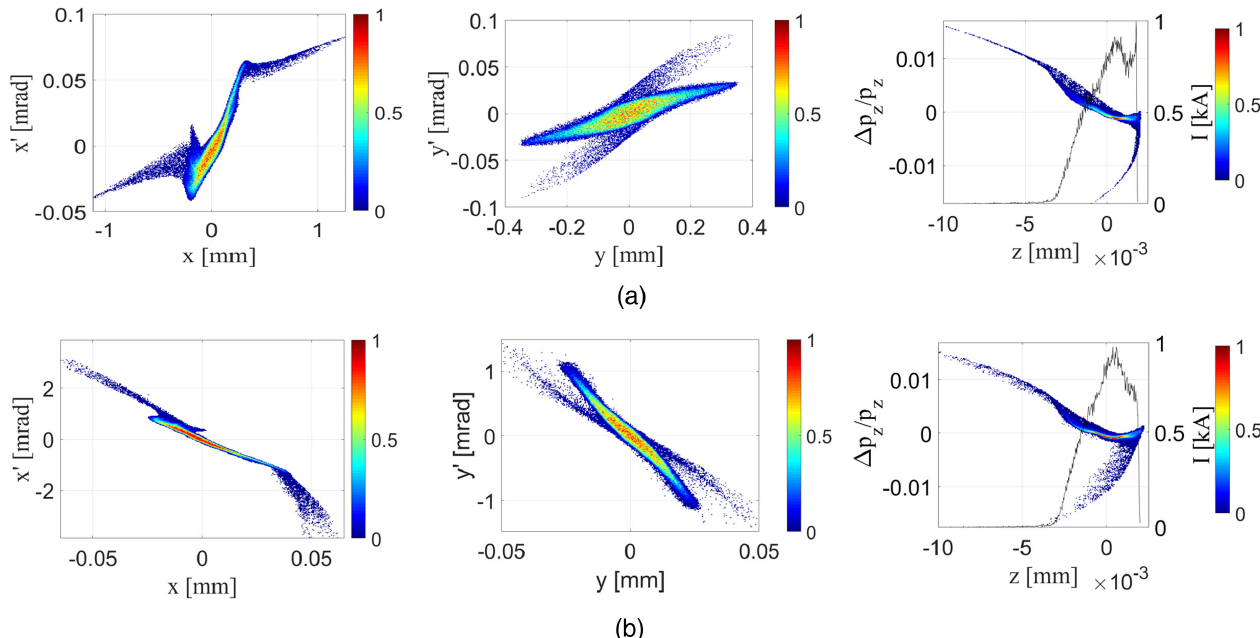
FIG. 6. Evolution of the transverse and longitudinal phase spaces, simulated in ASTRA , at (a) the BC exit and matched beam at (b) the entrance of the plasma cell. Color scales indicate normalized electron density.